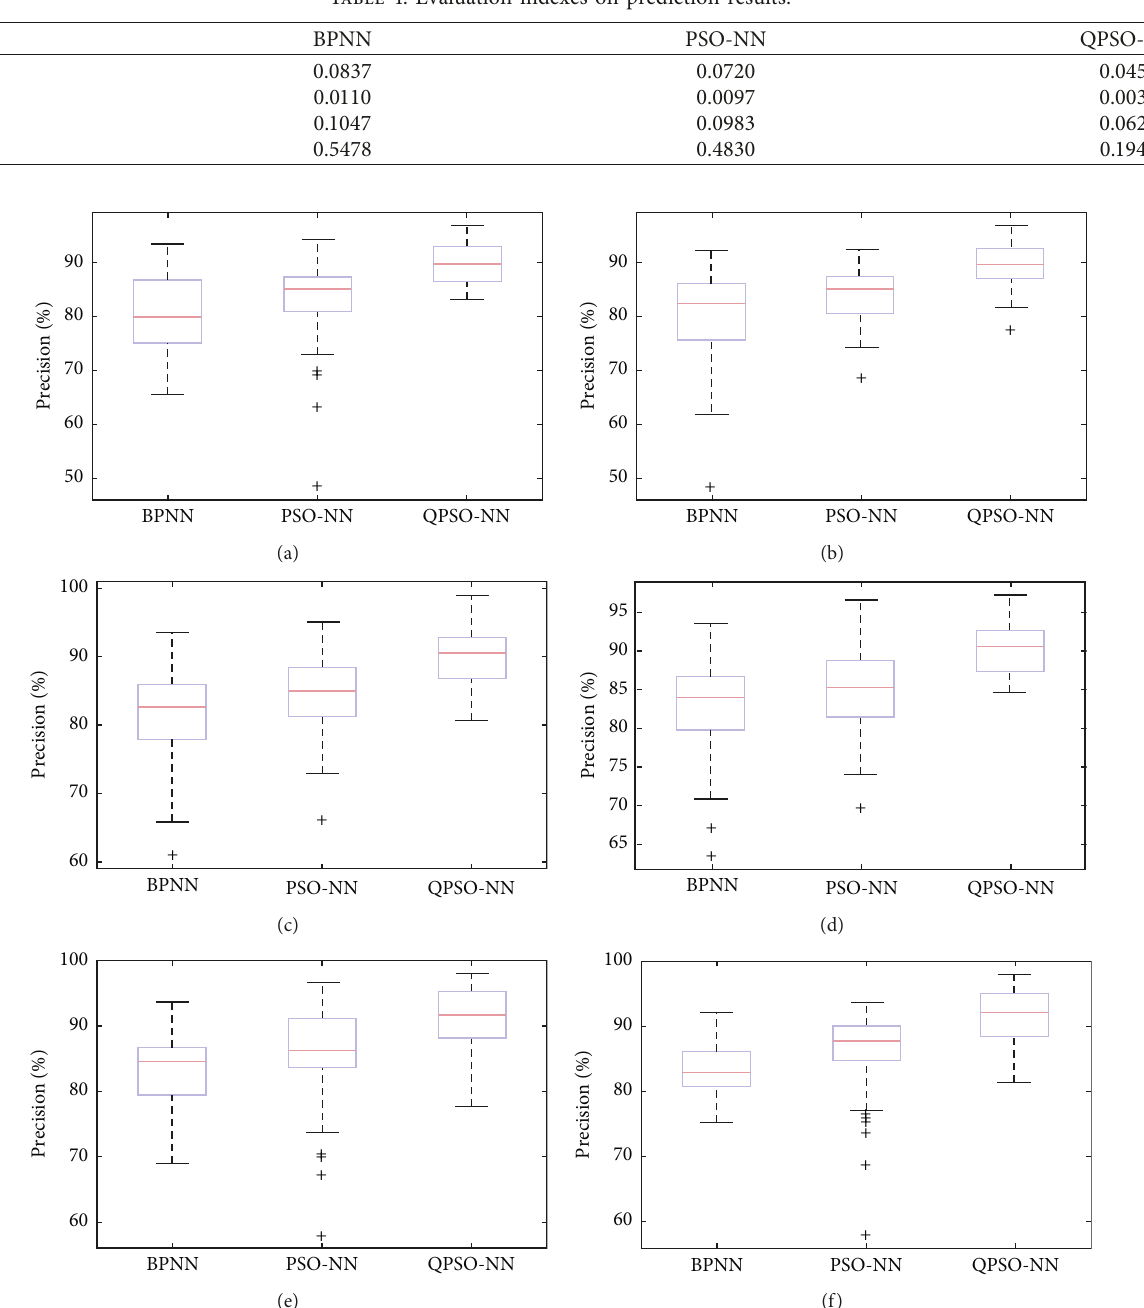
Table 4: Evaluation indexes on prediction